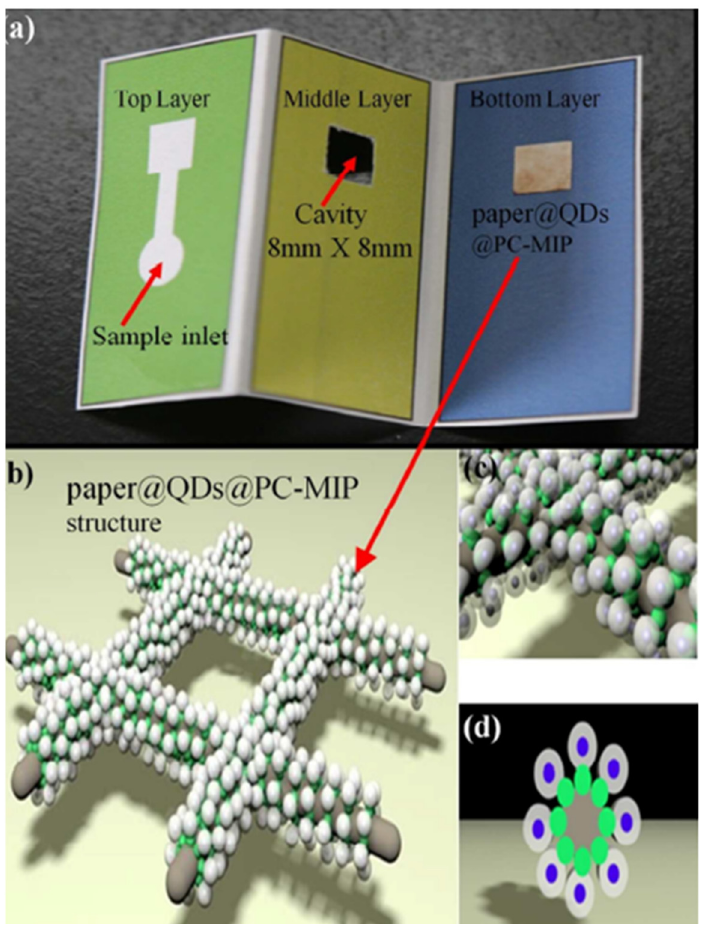
Figure 5. ( a ) Photograph of the paper@QDs@PC-MIPs µPADs; ( b ) Schematic illustration of the structure of the paper@QDs@PC-MIPs component; ( c , d ) Side and bottom view of enlarged diagram of the structure of the paper@QDs@PC-MIPs on cellulose paper. Green shell: fluorescent quantum dots; white shell: PC imprinting; gray column: cellulose paper. Reproduced with permission from [25]. Copyright 2017 American Chemical Society.